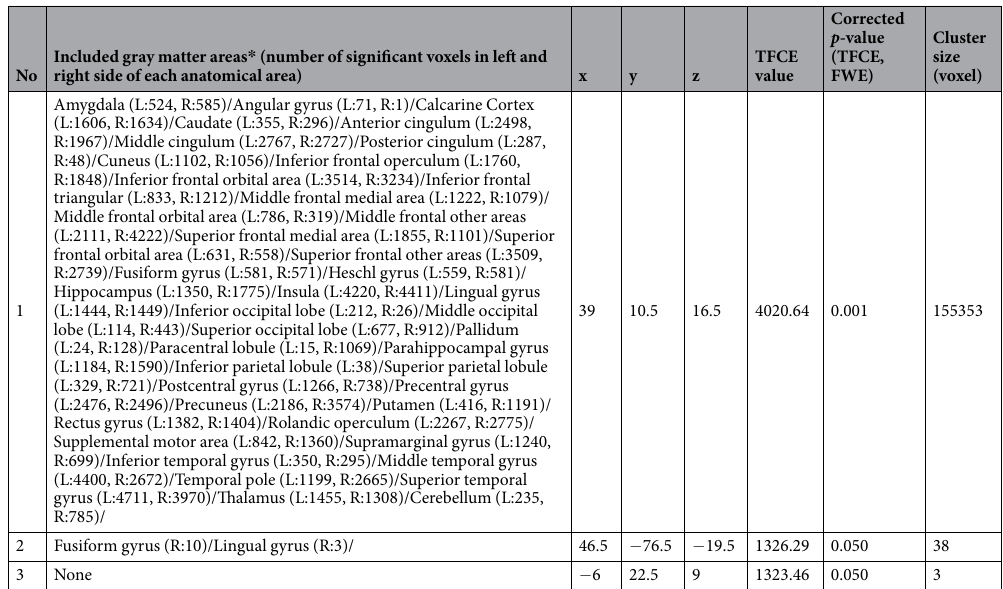
Included gray matter areas * (number of significant voxels in left and No right side of each anatomical area)